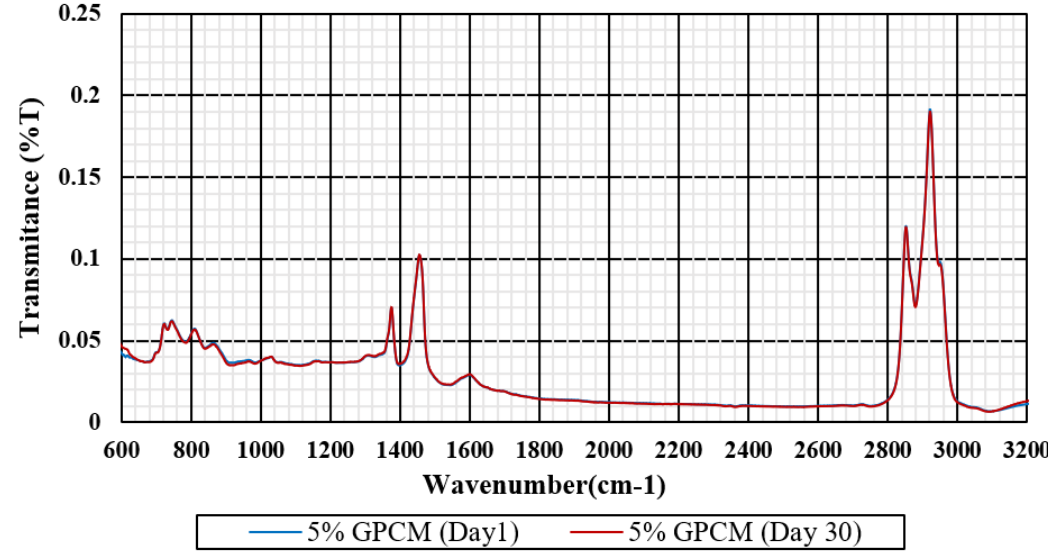
Figure 11. FTIR spectrum of the 5%PCM samples under different storage conditions .